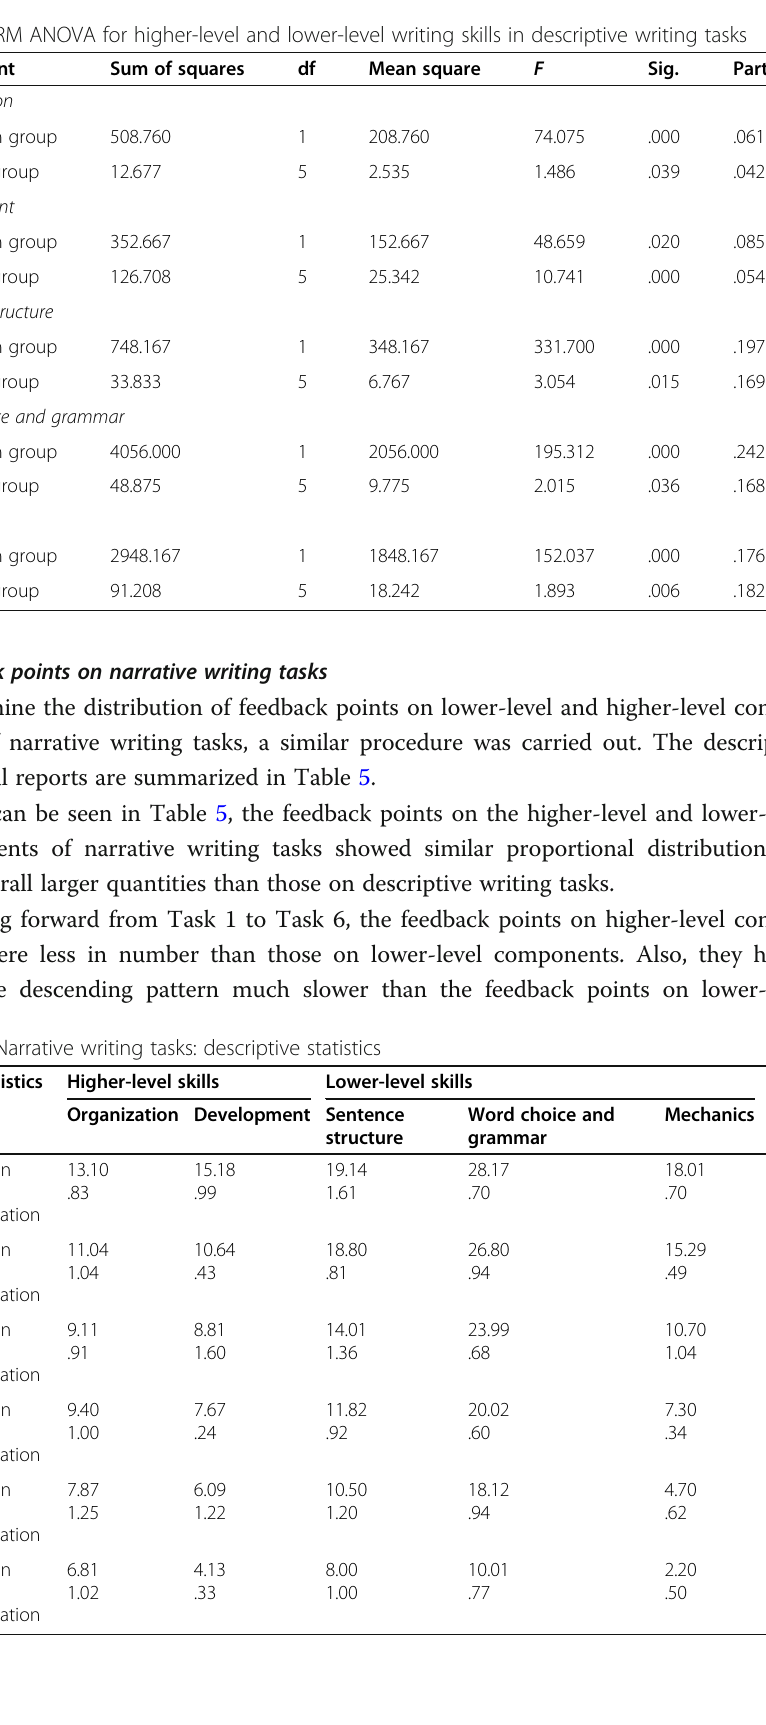
Table 4 RM ANOVA for higher-level and lower-level writing skills in descriptive writing tasks Component